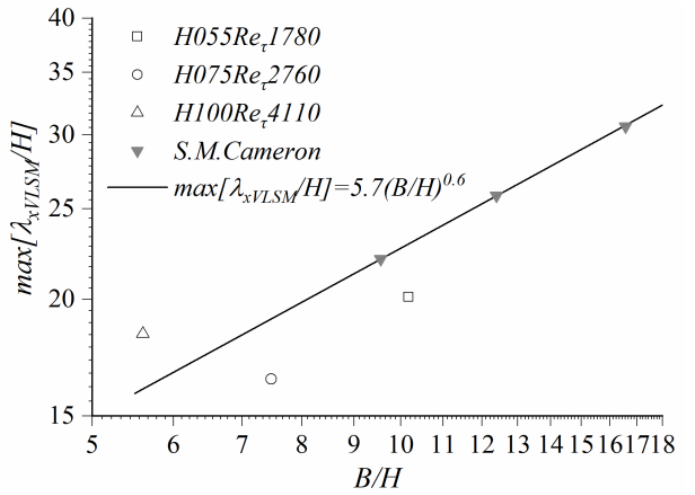
Figure 8. Maximum wavelength of VLSMs along the whole water depth versus flow aspect ratio. To inspect the validity of Cameron et al. who proposed a relationship for the maximum wavelength of VLSMs along the whole water depth and flow aspect ratio, the results of the present irregularly arranged rough-bed OCF and those of Cameron et al. for a regular rough-bed OCF are depicted in Figure 8. Although the experimental data obtained by Cameron et al. for a regular rough-bed OCF satisfy well with the empirical relationship, the experimental data of the present study for the irregularly arranged rough-bed OCF exhibit deviations from the empirical curve. Considering this, the relationship proposed by Cameron et al. is not universal and must be revisited in the